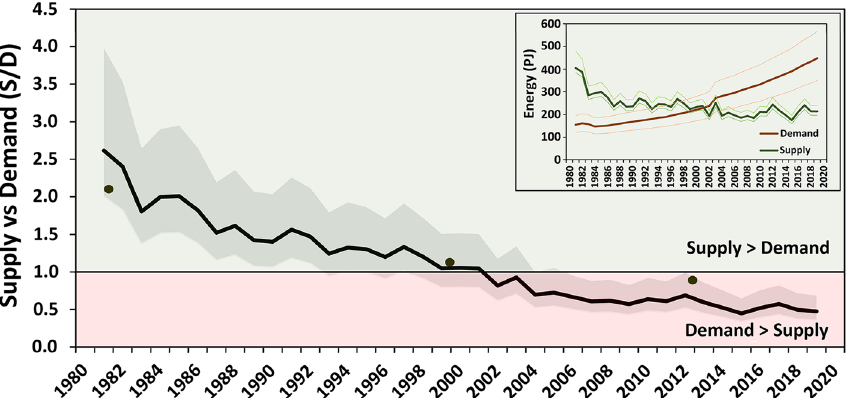
Figure 6. Time series and the derivation of energy supplied from the main feed resources (grass, crop residue, and brows)/energy demand of the livestock population (S/D) in the study area for the historical period of 1981 to 2020. The inset graph shows the average demand and supplied ME in Petajoule (PJ) per year. The black dots represent result if year-specific land-use maps for the years 1981, 2000, and 2013 are used. The shaded area enclosing the S/D line represents the uncertainty of simulations as originating from parametric uncertainties (Table S.1). The figure was generated using Microsoft Excel 2016 (https:// www. micro soft. com/ de- de/ micro soft- 365/